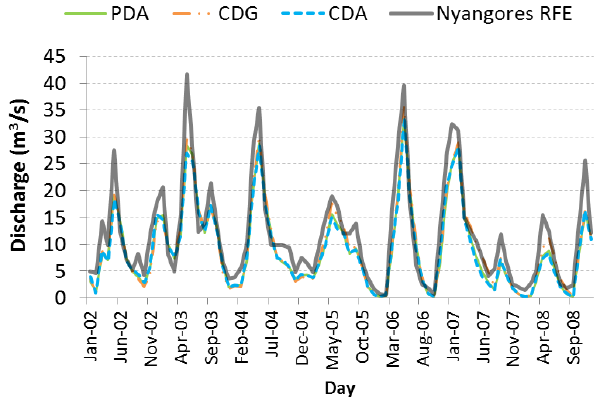
Figure 7. Nyangores River simulated monthly discharge for land use scenarios. PDA = Partial Fig. 7. Nyangores River simulated monthly discharge for land Deforestation, Conversion to Agriculture, CDG = Complete Deforestation Conversion to use scenarios. PDA=Partial Deforestation, Conversion to Agricul- Grassland, and CDA = Complete Deforestation Conversion to Agriculture. ture, CDG=Complete Deforestation Conversion to Grassland, and CDA=Complete Deforestation Conversion to Agriculture.